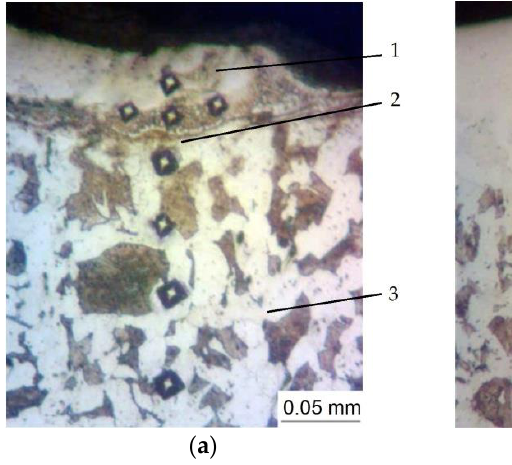
Figure 2. The microstructures of the nitrided surface layers of the steel C22 specimens having the aluminum sublayer and processed with the use of the ESA method by the electrode-tool made of steel C22 at the discharge energy (W р ): ( a ) — W р = 0.13; ( b ) — W р = 0.52 and ( c ) — W р = 3.40 J, 1 —“ white layer ” , 2 — the diffusion zone, 3 — the base metal.